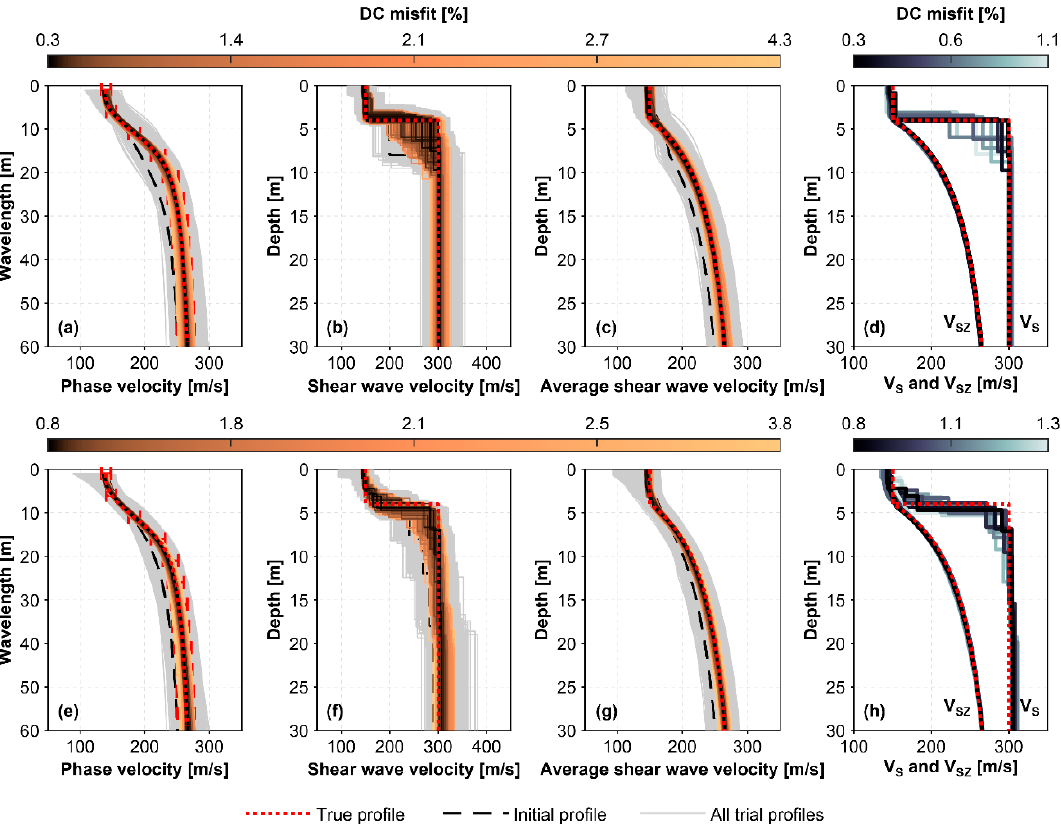
Figure 7. Inversion of the unperturbed synthetic dispersion curve from model A. A geologic structure consisting of ( a – d ) four and ( e – h ) eight layers was assumed. Gray areas display all sampled models and profiles whose dispersion curves deviate less than 5% from the synthetic curve at all wavelengths are shown using a color scale based on dispersion misfit values. The lowest dispersion misfit V S - and V SZ -profiles within each independent set of 1000 iterations are shown in ( d ) and ( h ).